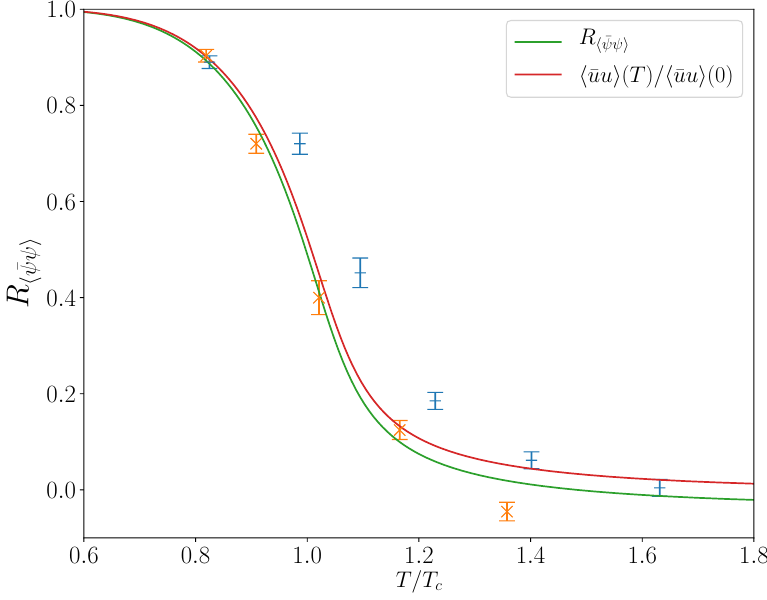
Figure 3. The relative-temperature T / T c dependence of the subtracted (and normalized) condensate R ⟨ ¯ ψψ ⟩ defined by Equation (17) and introduced by Ref. [81]. The lattice data points are from Figure 6 of Ref. [82], but scaled for the critical temperatures T χ from their Table 2, which is different for the “crosses” (data points [82] for m π ≈ 370 MeV) and “bars” (data points [82] for m π ≈ 210 MeV). The lower, green curve results from the R ⟨ ¯ ψψ ⟩ (17) subtraction of our u -quark condensate. The upper, red curve is the T -dependence of our u -quark condensate when regularized in the usual way (see text).